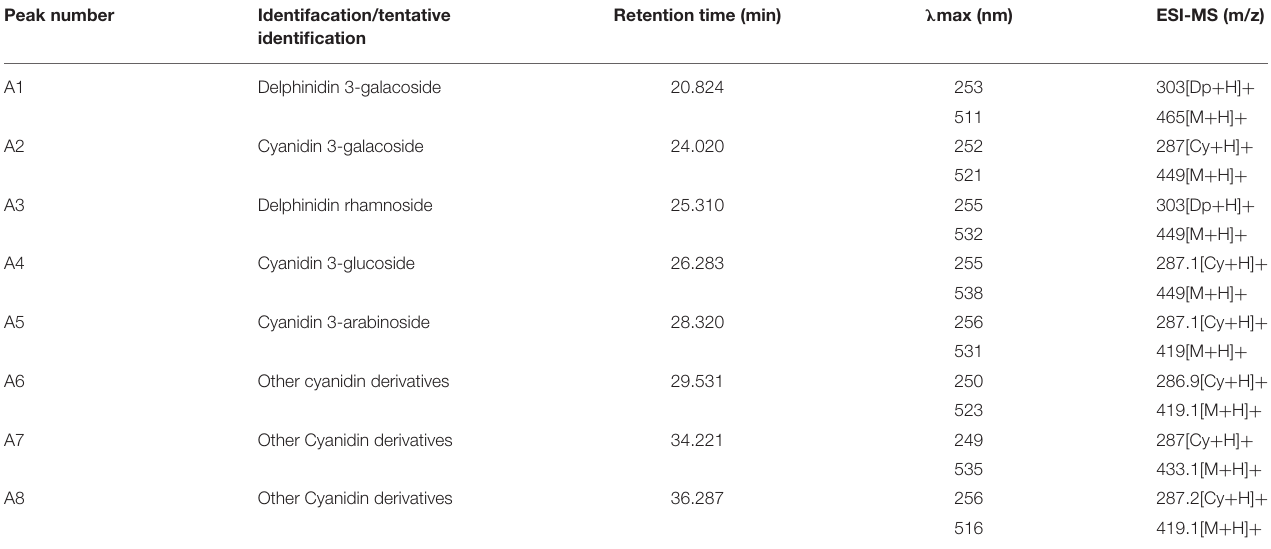
TABLE 1 | The anthocyanin profiles in acidic MeOH-H 2 O extracts of the R. delavayi . Peak